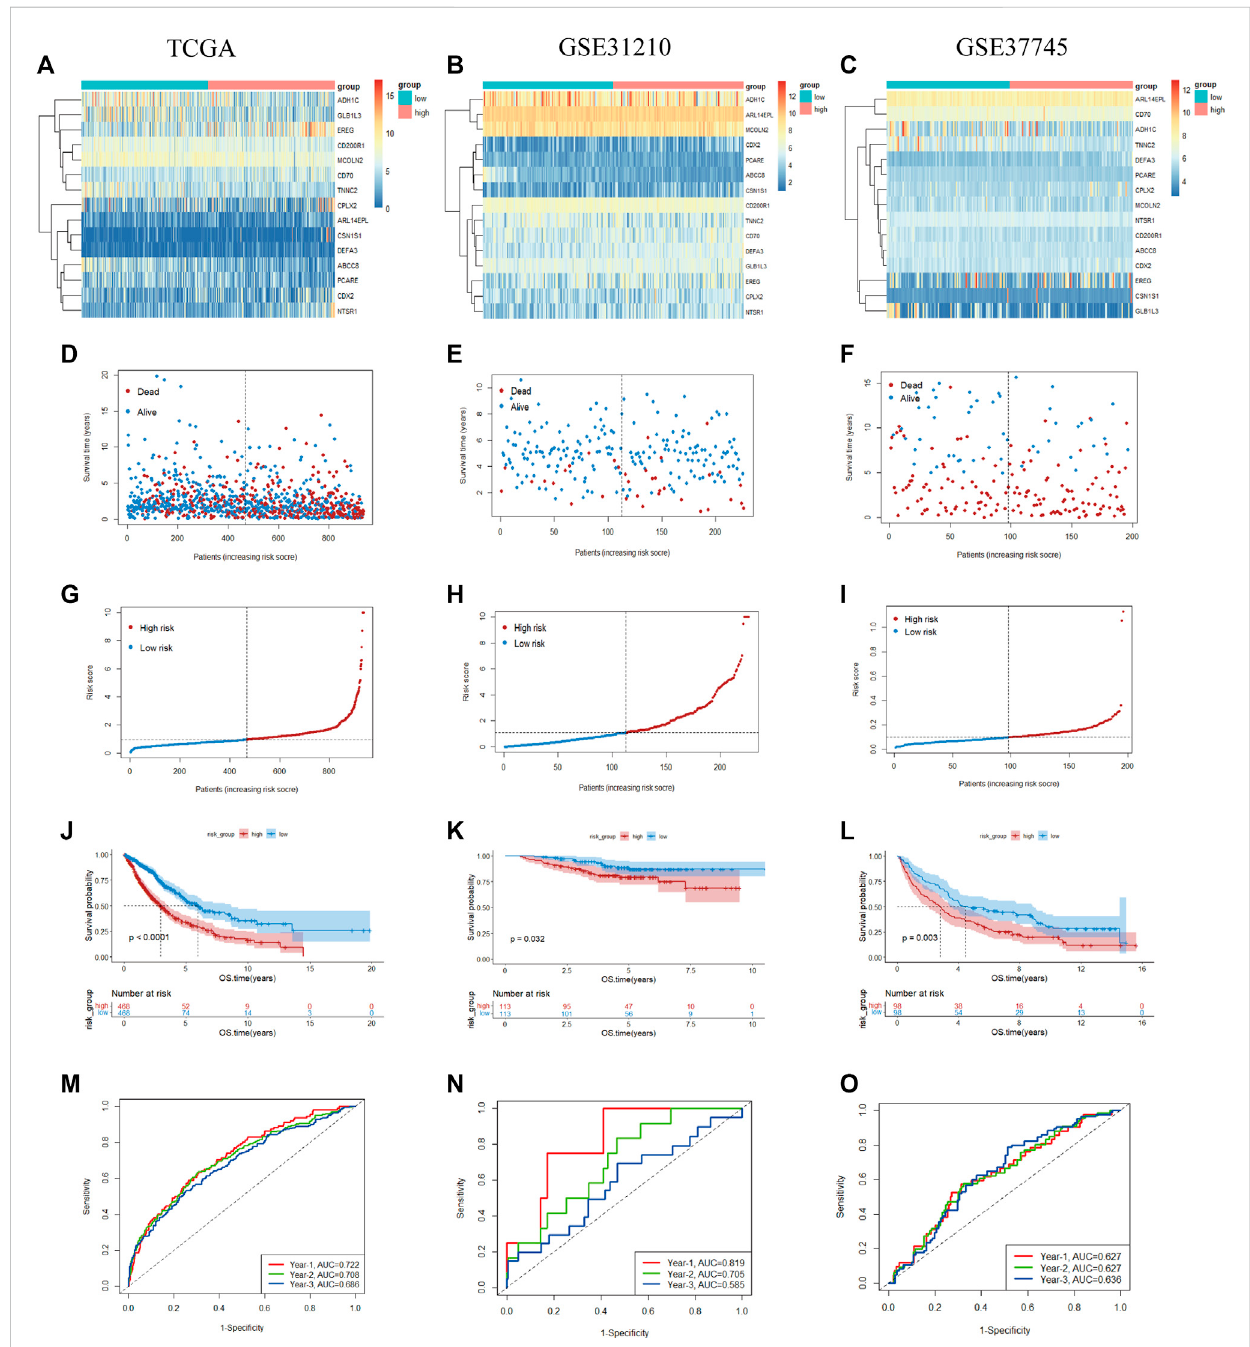
FIGURE 5 Prognostic value of the 15-gene prognostic model in the TCGA and validation cohorts (A – C) . Heatmap of fi fteen genes between the two groups in the TCGA and validation sets (D – F) . Risk score scatter plot. Red dots indicate dead patients, and blue dots indicate alive patients (G – I) . Risk score curve plot. The dotted line indicates the individual distribution of the risk score, and the patients are categorized into low-risk (blue) and high-risk (red) groups (J – L) . Survival status and time of patients between the two groups in the TCGA and validation sets, respectively (M – O) . The time-dependent ROC curve of patients between the two groups in the TCGA and validation